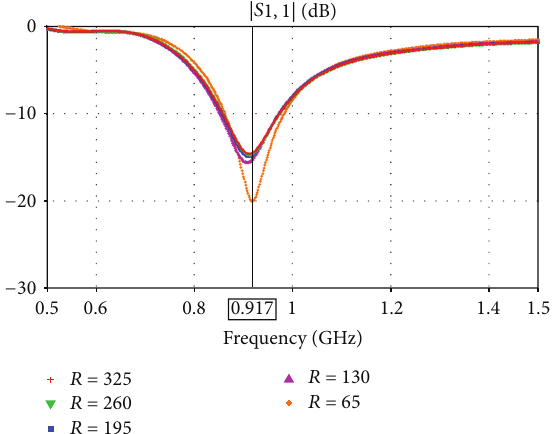
Figure 15: Resonance frequency of five-layers strip dipole antenna with difference curving radius (millimeters).